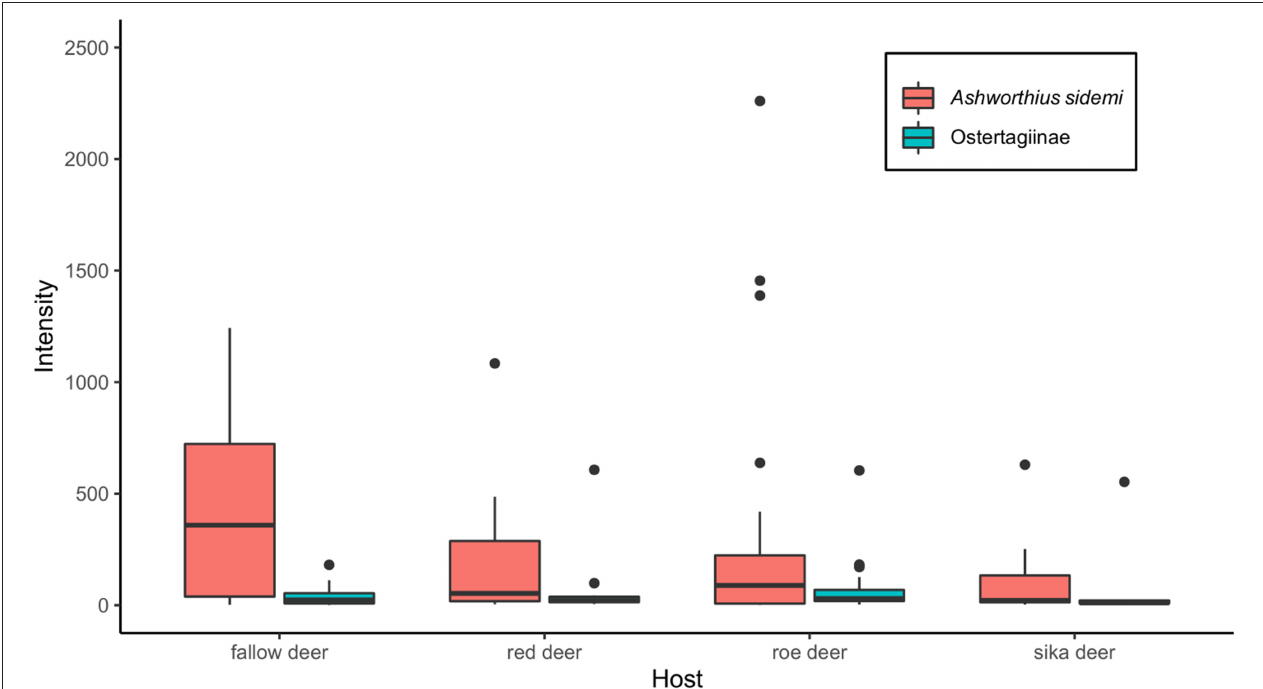
FIGURE 3 | Median intensity of both Ashworhius sidemi and nematodes from the subfamily Ostertagiinae in the evaluated cervid host species presented as boxplot. Black dots symbolize outliers.